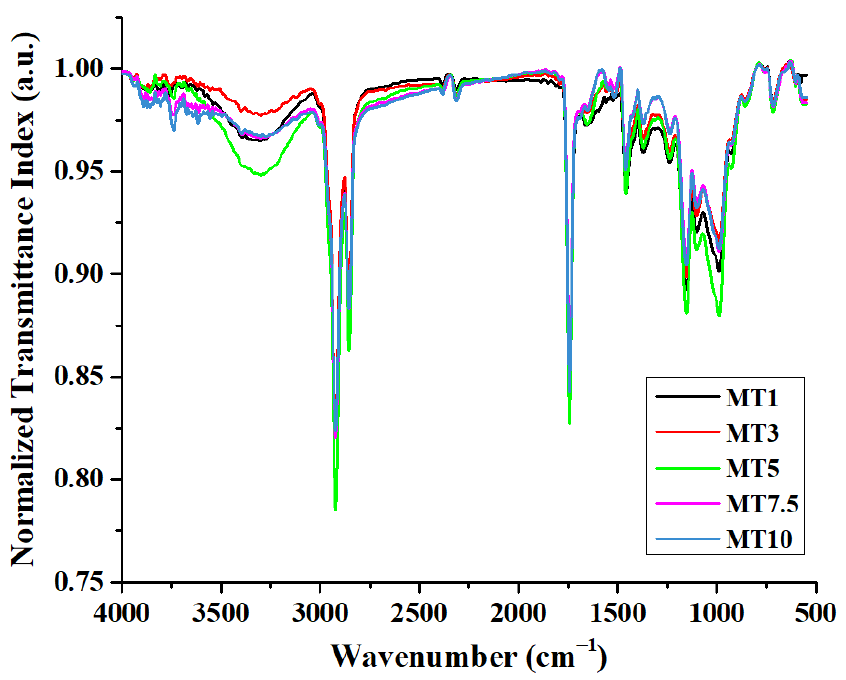
Figure 15. FTIR spectra of cookie samples.